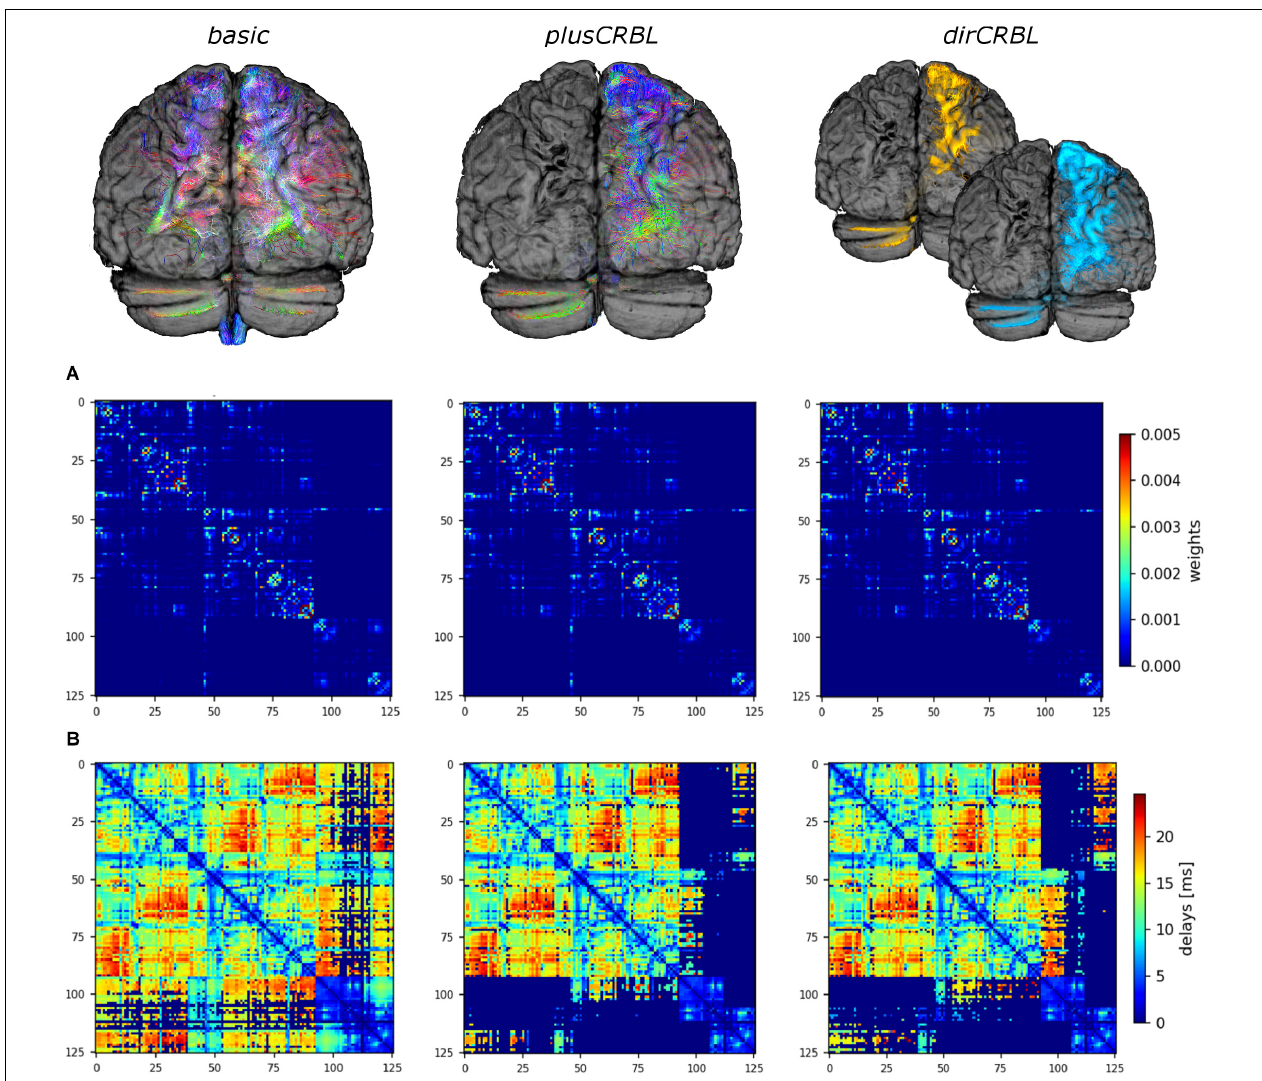
FIGURE 2 | Structural connectome (SC) and time delay matrices. The top row shows the cerebro-cerebellar connectivity considered in each SC construct. For clarity only tracts connected to the left hemisphere of the cerebellum are shown. From left to right: basic (all tracts, including the spurious ones) , plusCRBL (contralateral tracts only) , dirCRBL (directional contralateral tracts). In basic and plusCRBL cerebellar connections are color coded with standard tractography rules (i.e., red for streamlines following left-to-right direction, green for anterior-posterior, and blue for superior-inferior), while, in the dirCRBL, yellow refers to efferent cerebellar connections and light blue refers to afferent ones to highlight anatomically inferred directionality. The middle row (A) shows the structural connectivity matrices, while the bottom row (B) shows the time delay matrices. All matrices refer to an SC construct in a randomly chosen subject.